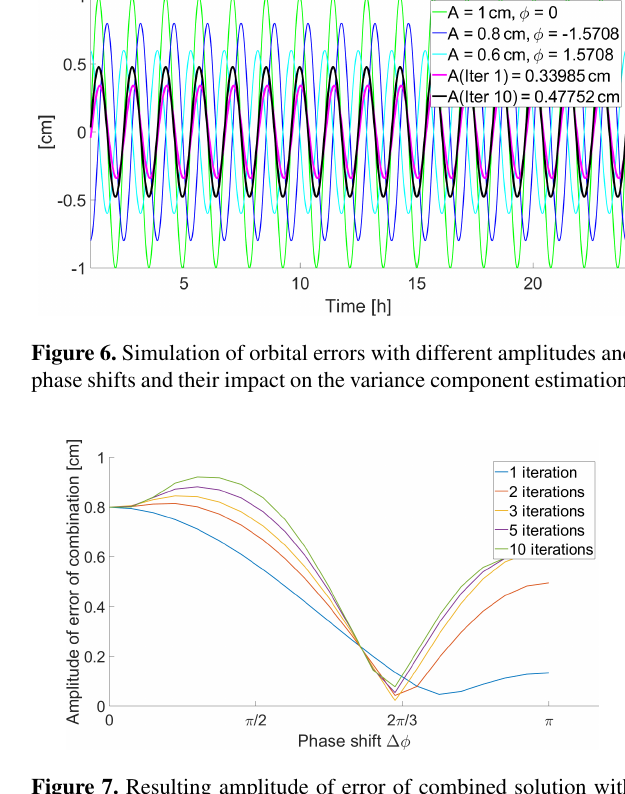
Figure 5. Combination of solutions affected by white noise using the weighting scheme adopted by the IGS.